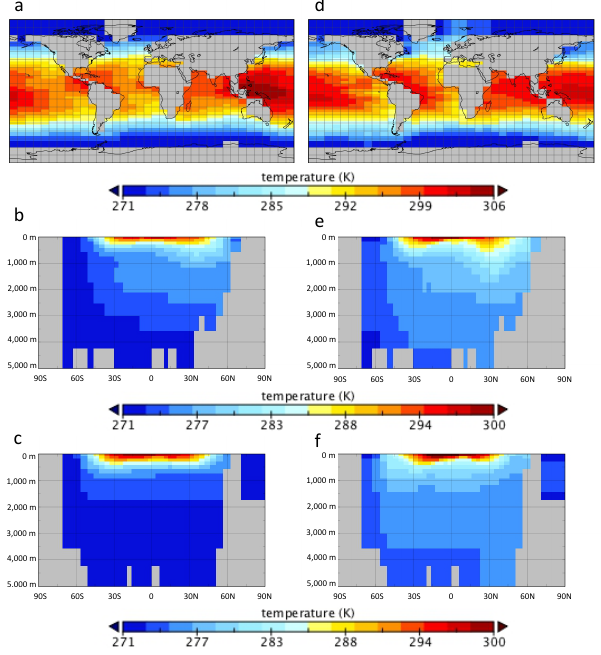
Fig. 4. Salinity: (a) , (b) and (c) EFPC ensemble averages, (d) , (e) and (f) observations (Antonov et al., 2006). Upper panels are surface fields. Middle panels are Atlantic cross sections (25 ◦ W). Lower panels are Pacific cross sections (155 ◦